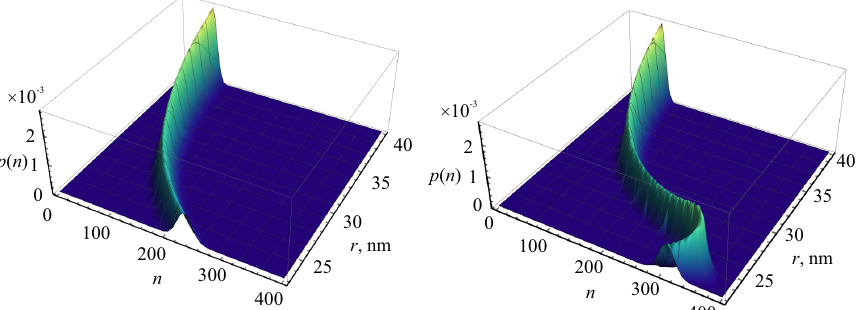
Figure 11. Probabilities p ( n , T ) in relation to the coordinate r of a QE with respect to an NP for the cases of an ideal spherical NP with ε = − ∞ ( left ) and for a silver NP with ε = − 15.37 + i 0.231 ( right ) at θ = π /6 rad for T = 9 µ s, D = 0, λ = 632.8 nm and ∆ ω L = 1